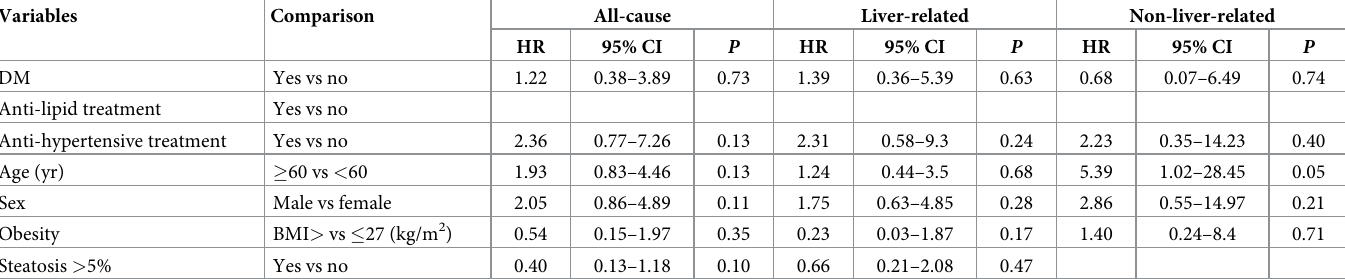
Table 10. Features Associated With Mortality In Advanced Fibrotic patients (fibrosis score 3–4) with SVR (N = 438) According to Cox Proportional Hazards Model:Results of Multivariate